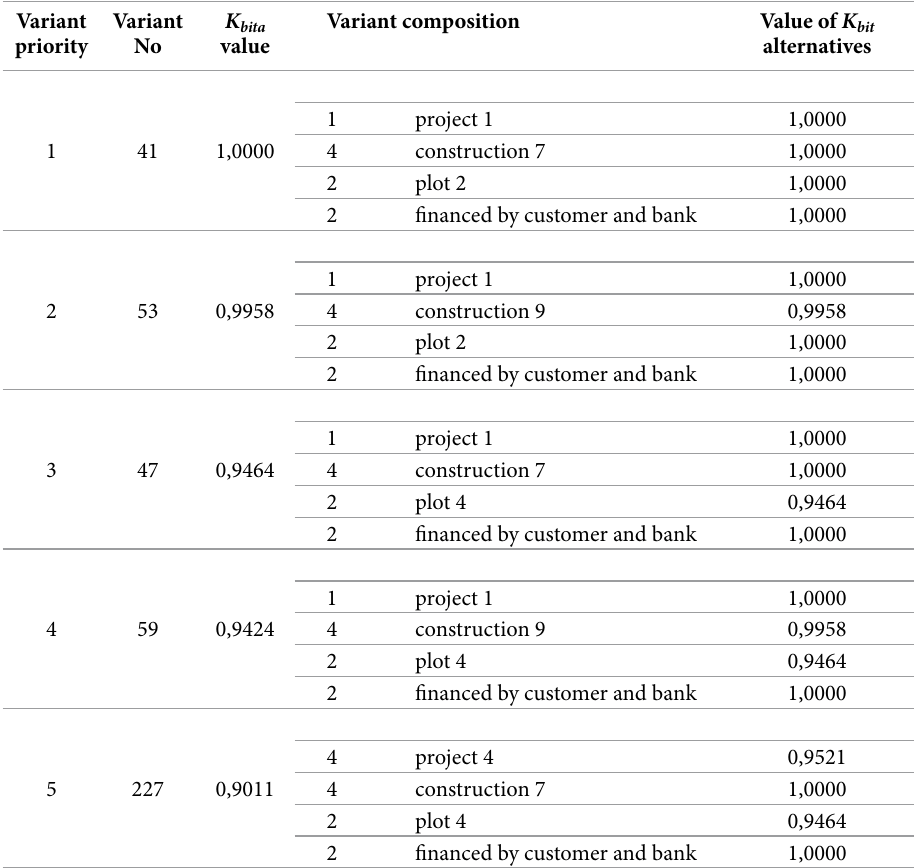
Table 6. Determination of the most efficient construction variant for a dwelling house using project multiple criteria evaluation synthesis method DSS1. The data of 5 best